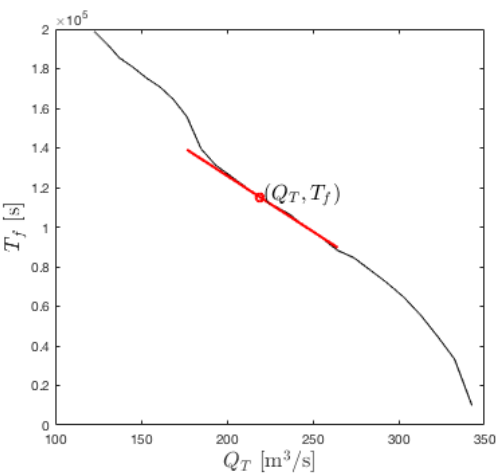
Figure A1. Flood duration as an implicit function of threshold discharge, T f = T f ( Q T ) (black line), for the Boxing Day flood at Armley gauge station. The red line shows a linear approximation local to Q T = 219 m 3 /s, the gradient of which is used to approximate ∂ T f / ∂ Q T in the FEV error calculation (A3). In this case, ∂ T f / ∂ Q T ≈ − 564 m − 3